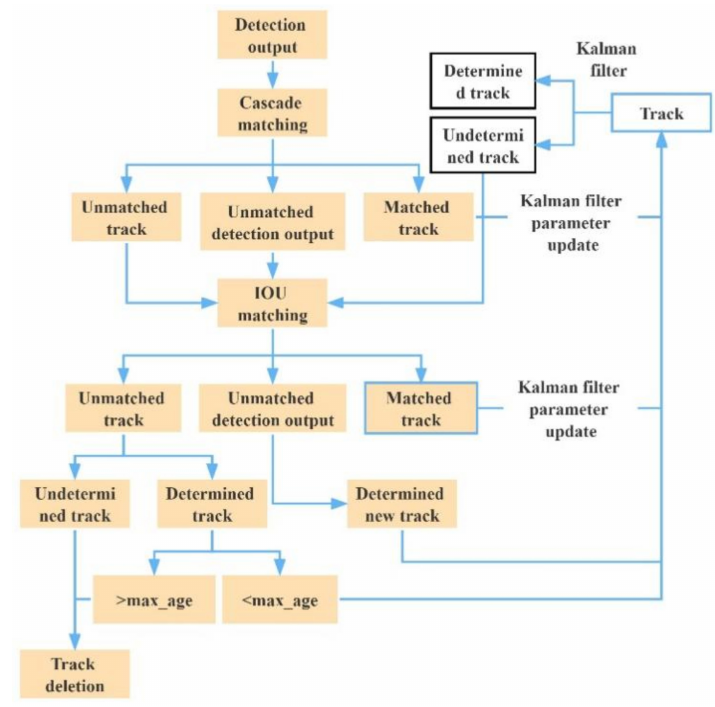
Figure 7. Process flow of Deepsort